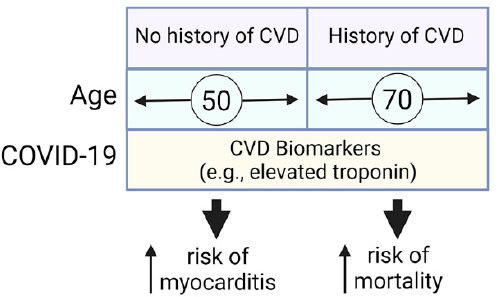
Figure 4. Summary of results. We compared patients with a history of cardiovascular disease (CVD) to those with no history and found that patients with a history of CVD were an average age of around 70 years old compared to patients without a history of CVD that were significantly younger, around age 50 years. Older patients with a history of CVD had an increased risk of mortality of around 10% compared to younger patients without a history of CVD at around 2%. COVID-19 led to an increase in many CVD biomarkers associated with myocardial damage and heart failure such as troponins and NT-proBNP. Patients with elevated CVD biomarkers from COVID-19 had increased risk of developing myocarditis in younger patients without a history of CVD and increased mortality in older patients with a history of CVD.